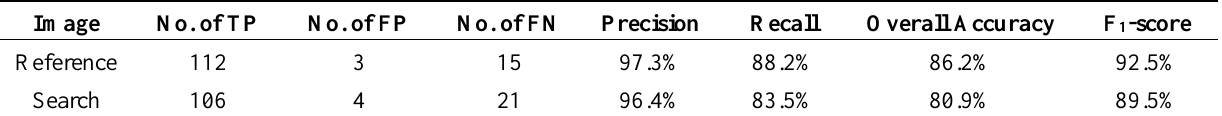
Table 2. Quantitative assessment of the proposed façade regional feature detection method.